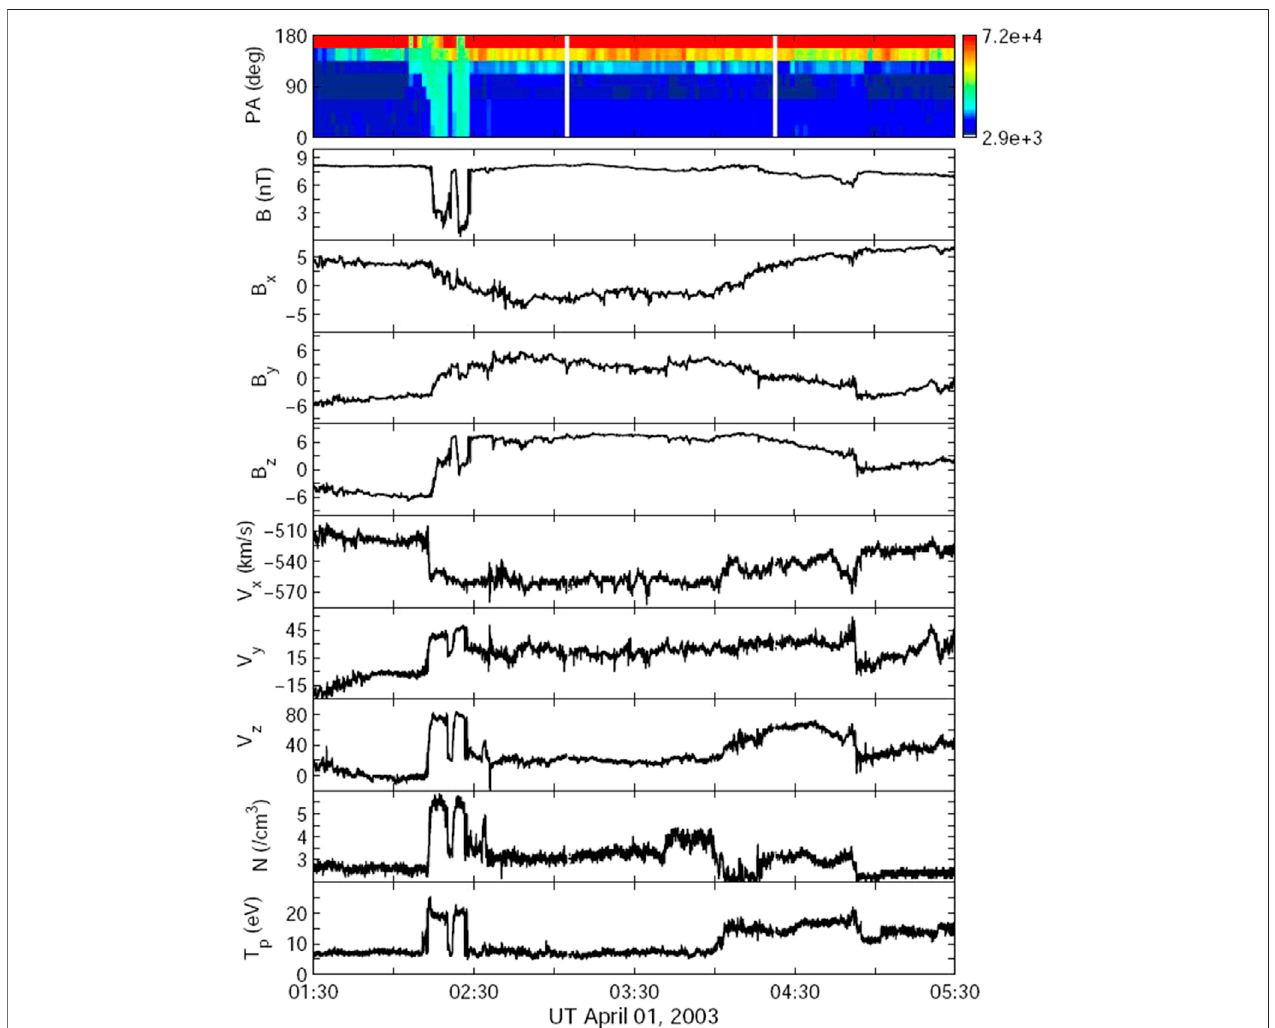
FIGURE 1 | Suprathermal electron pitch angle spectrogram of 165.0 eV, magnetic fi eld, and proton temperature data measured by Wind on April 1, 2003 on the basis of the magnetic reconnection exhaust and the following faster fl ow.